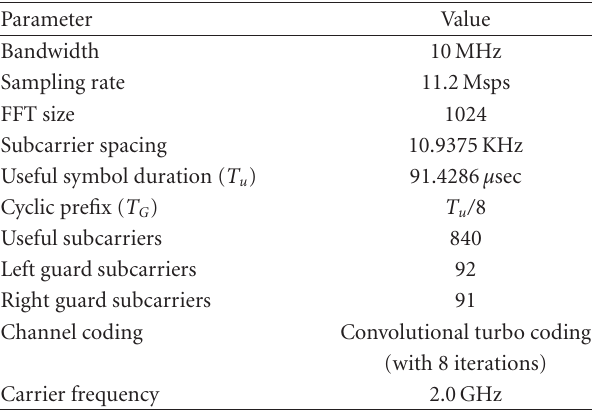
Table 1: Simulation